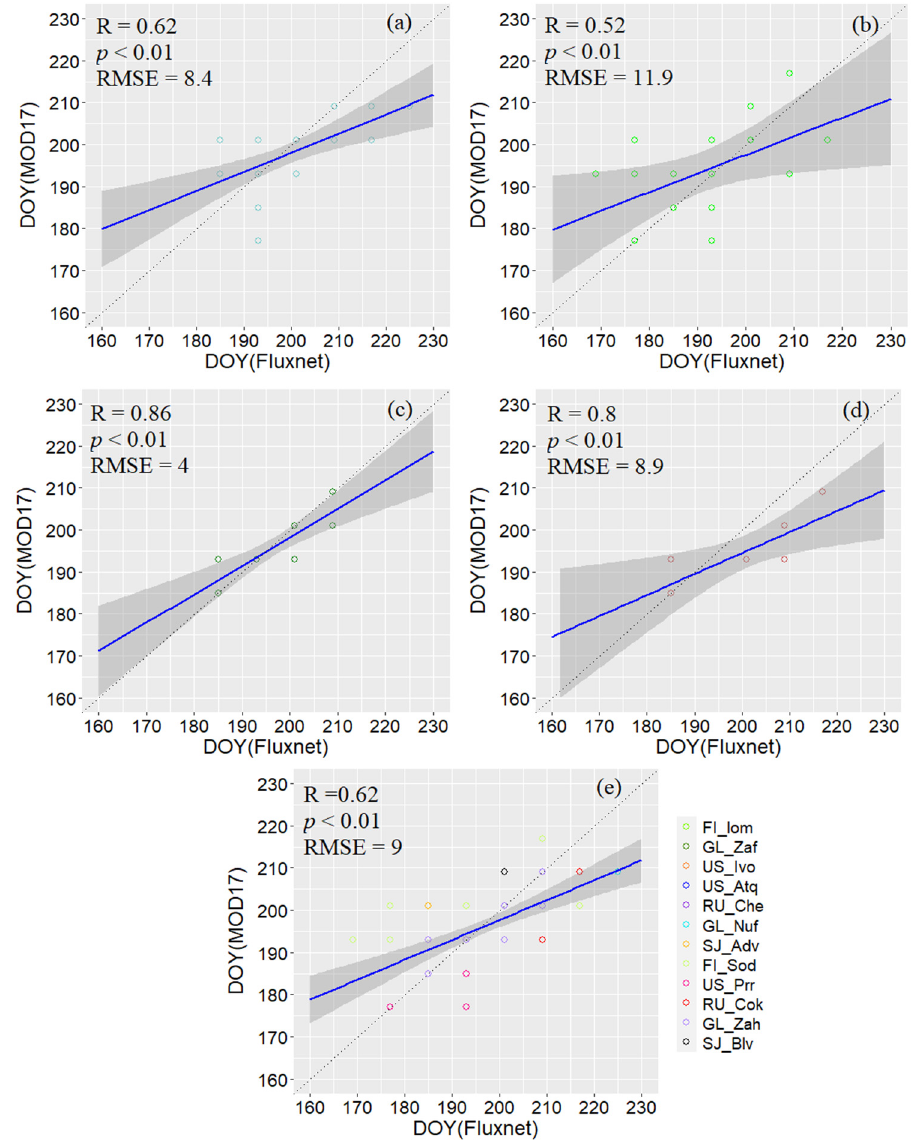
Figure 9. The DOY comparison of the timing of the maximum GPP between the sites and MOD17A2H. ( a – e ) Represent permanent wetlands, forests, grasslands, shrublands, and all sites combined, respectively. The gray belt refers to the confidence interval of 95%. Figure 11a,b display the distribution of GPP with latitude and elevation,